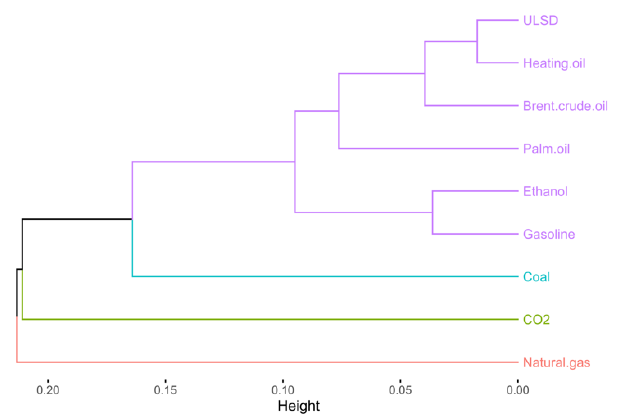
( b ) Figure 6. Alignment plots for gasoline and natural gas for the full period. ( a ) Two-way, ( b ) Three- way. On the two-way plot the black solid line for gasoline, the red dashed line for natural gas. Source: own elaboration on the basis of data from www.stooq.com (accessed on 19 April 2021). The courses of gasoline and natural gas prices are different to a large extent. Moreo- ver, they have visible phase differences. In the first period, the price of natural gas is ahead of the price of gasoline. Next, at the time of declaration of the state of pandemic, there was a deep decline in the price of gasoline, which was followed about just above three months later by the price of natural gas. After less than three months, the price of natural gas noted a steep increase, which was followed by the price of gasoline after about two months. On